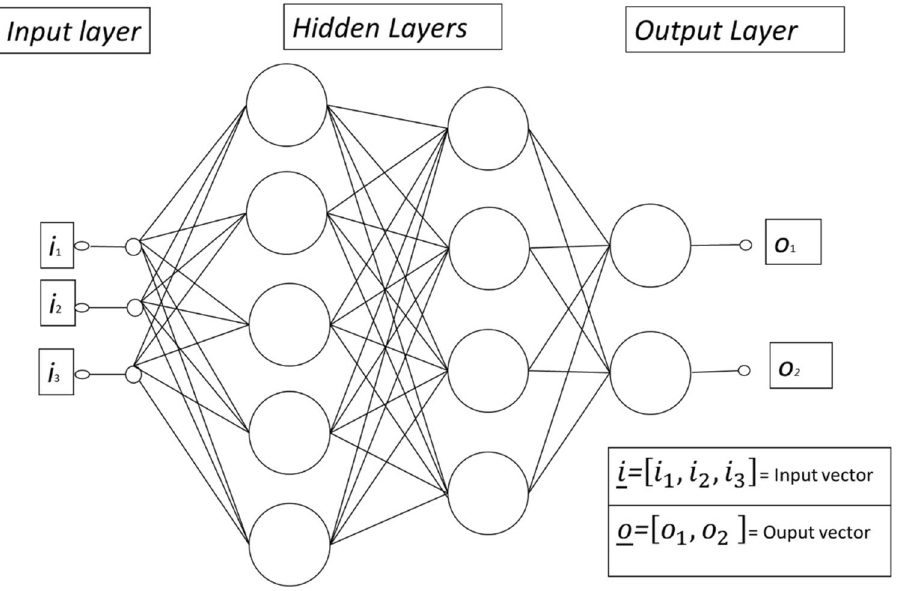
Figure 2. Multilayer perceptron with two hidden layers by Gardner and Dorling 115